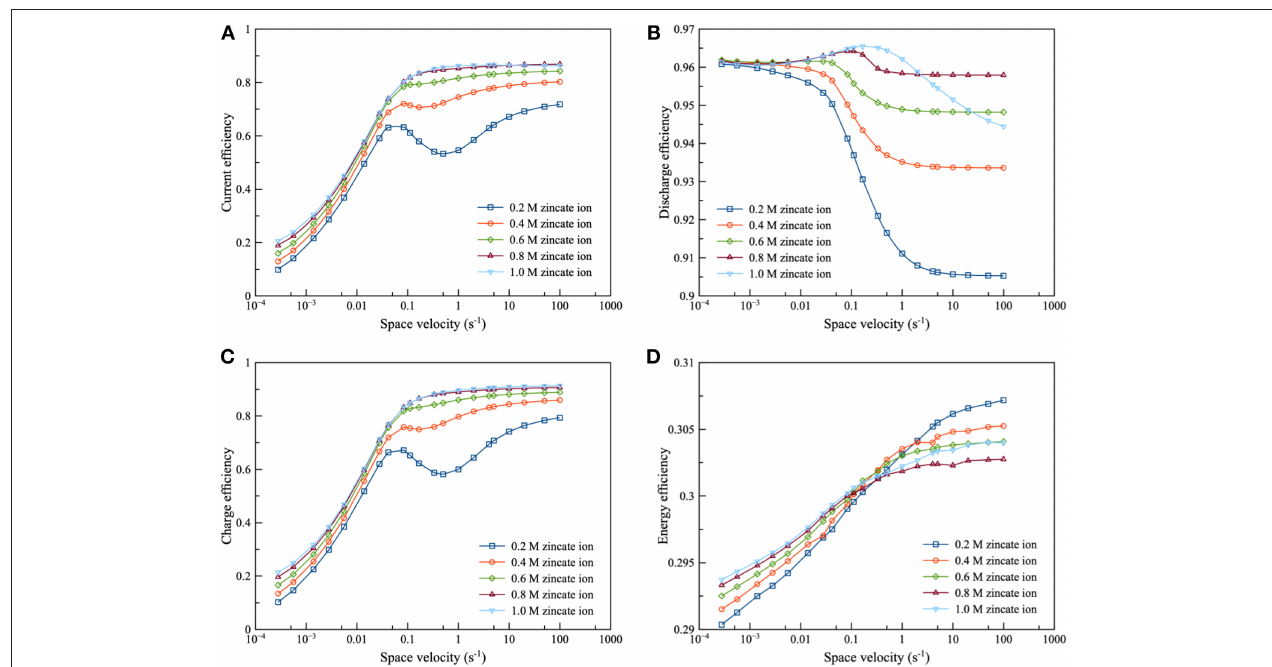
FIGURE 9 | Effects of zincate ion initial concentration using 8M KOH at charge and discharge current density of 100 mA/cm 2 : (A) current efficiency as a function of space velocity (B) discharge efficiency as a function of space velocity (C) charge efficiency as a function of space velocity and (D) energy efficiency as a function of space velocity.